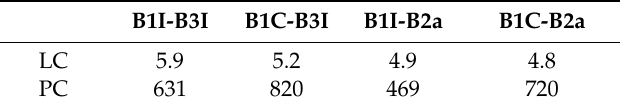
Figure 5. The phase and pseudorange ionosphere-free (IF) combination residuals as a function of epoch. Table 4. The root mean square (RMS) of B1I-B3I, B1C-B3I, B1I-B2a, B1C-B2a IF combination residuals in phase and pseudorange (units: mm).